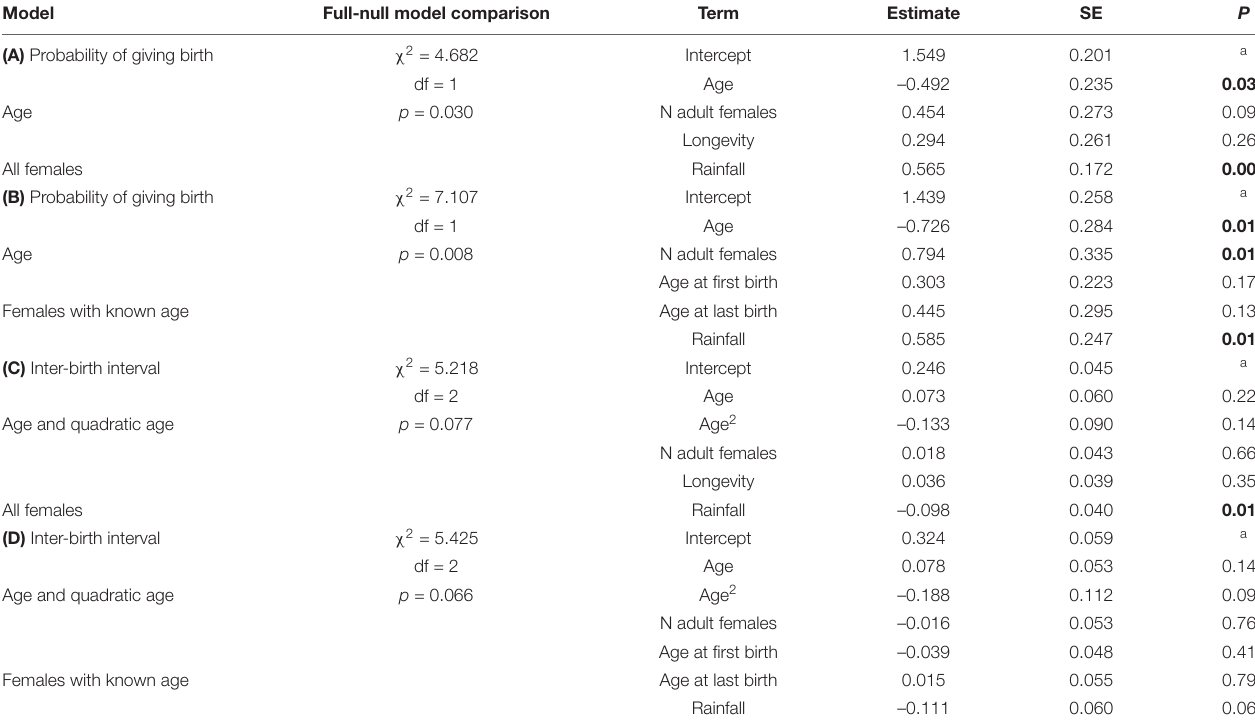
TABLE 5 | Results of the models in wild redfronted lemurs on (A) the probability of giving birth for all females, (B) for female’s with known age, and variation in interbirth intervals (C) for all females and (D) for females with known age. Model